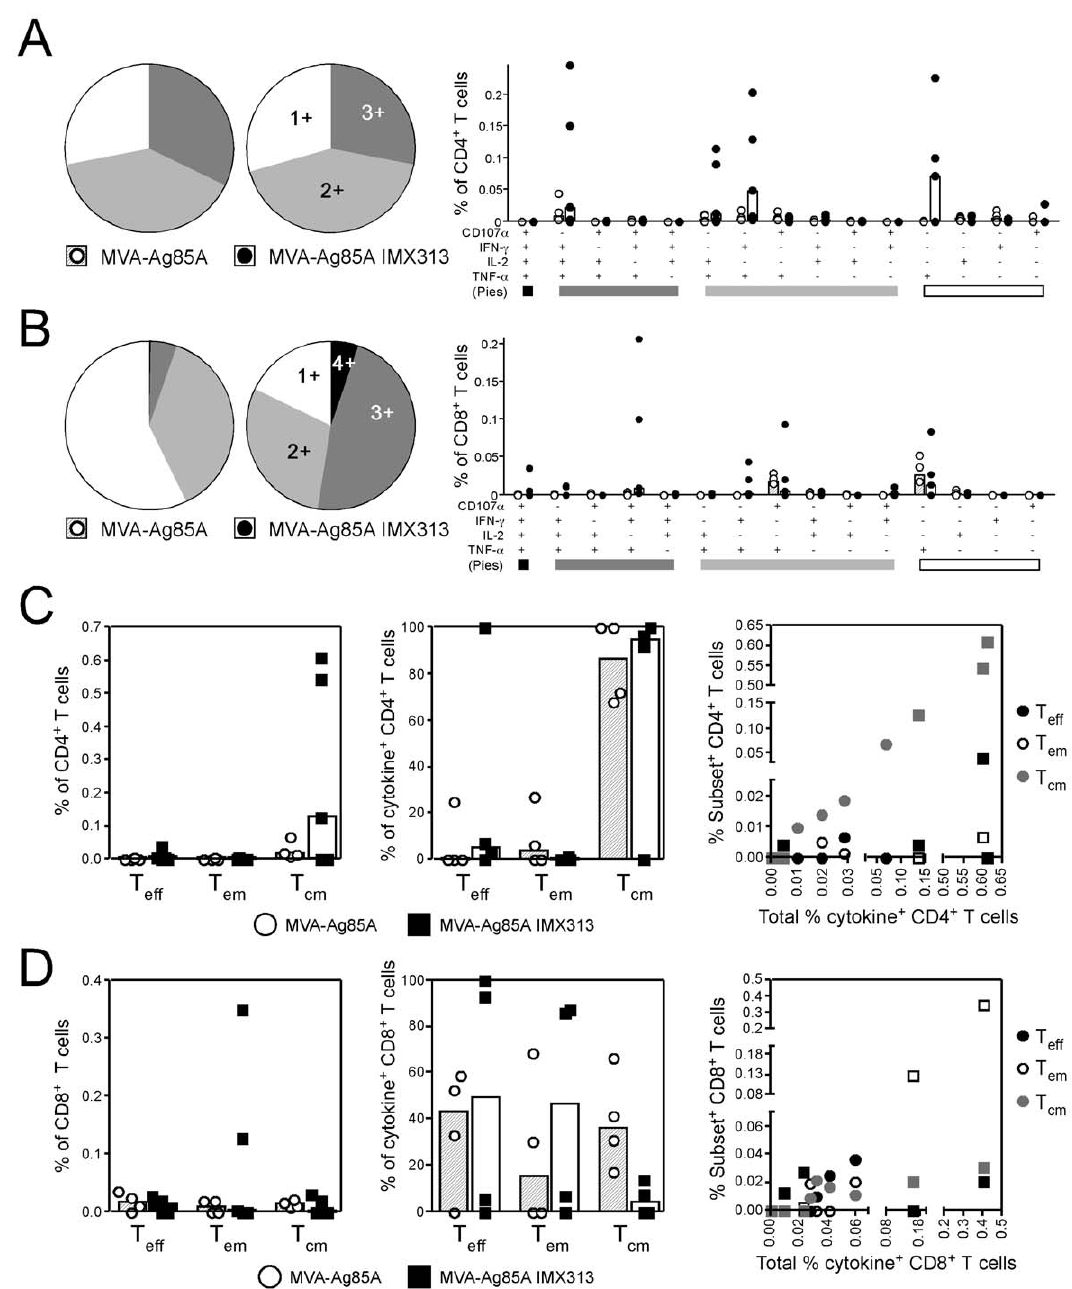
Figure 5. Quality of the response to antigen 85A in rhesus macaques 1 week after a homologous MVA-Ag85A boost. A & B ) Graphs represent the frequency of each cytokine producing subset as a percentage of all CD4 + ( A ) or CD8 + ( B ) T cells, while the pie charts represent the proportion of cytokine producing cells positive for 1, 2, 3 or all 4 markers. C & D ) Any cell positive for either CD107a, IFN- c , TNF- a or IL-2 was further subdivided into a CD28 + CD95 2 T eff , CD28 2 CD95 2 T em or CD28 + CD95 + T cm cell. Graphs on the left represent the absolute frequency of each memory population relative to the total number of CD4 + ( C ) or CD8 + ( D ) T cells, centre graphs represent the percentage of each population relative to cytokine producing cells, and graphs on the right represent total percentage of cytokine + cells compared to the percentage of each individual T cell population. For each graph the bars represent the median group response, with each animal displayed as a single point. Data were analyzed with a 2- way analysis of variance, no statistical difference between the two groups of vaccinated animals was observed.